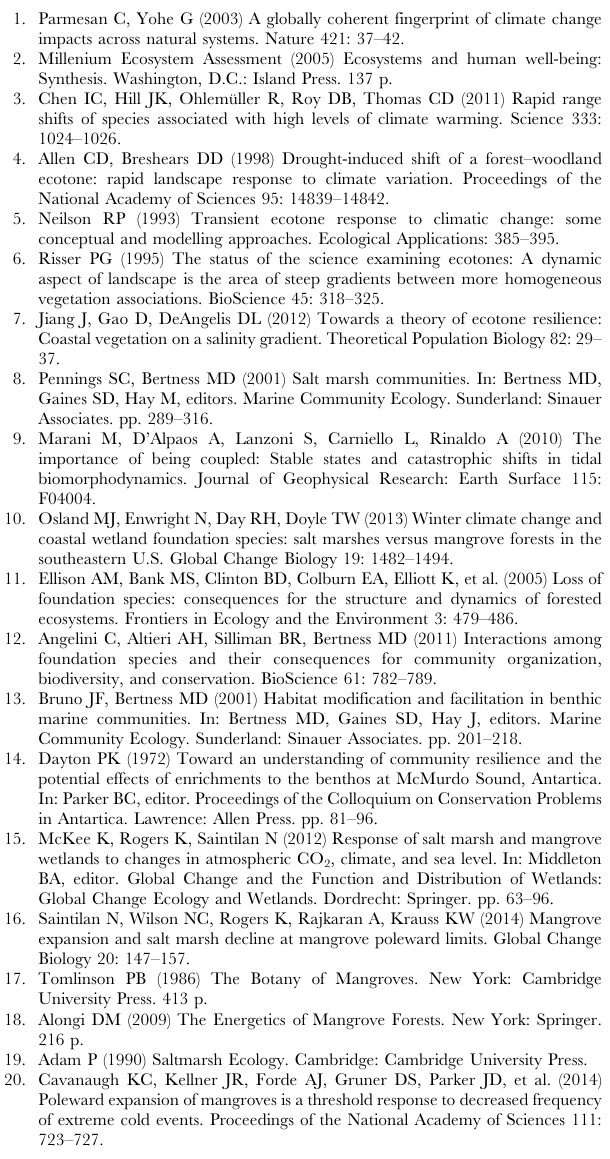
Table S1 Additional allometric regression equations for freeze-affected black mangrove ( Avicennia germinans )